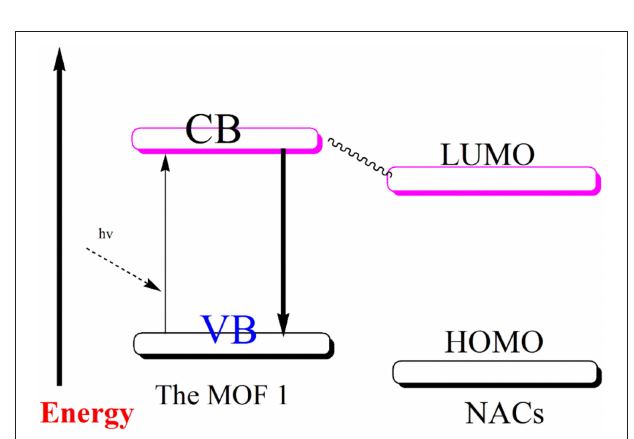
SCHEME 1 | The schematic illustration of the electron transfer process between 1 and